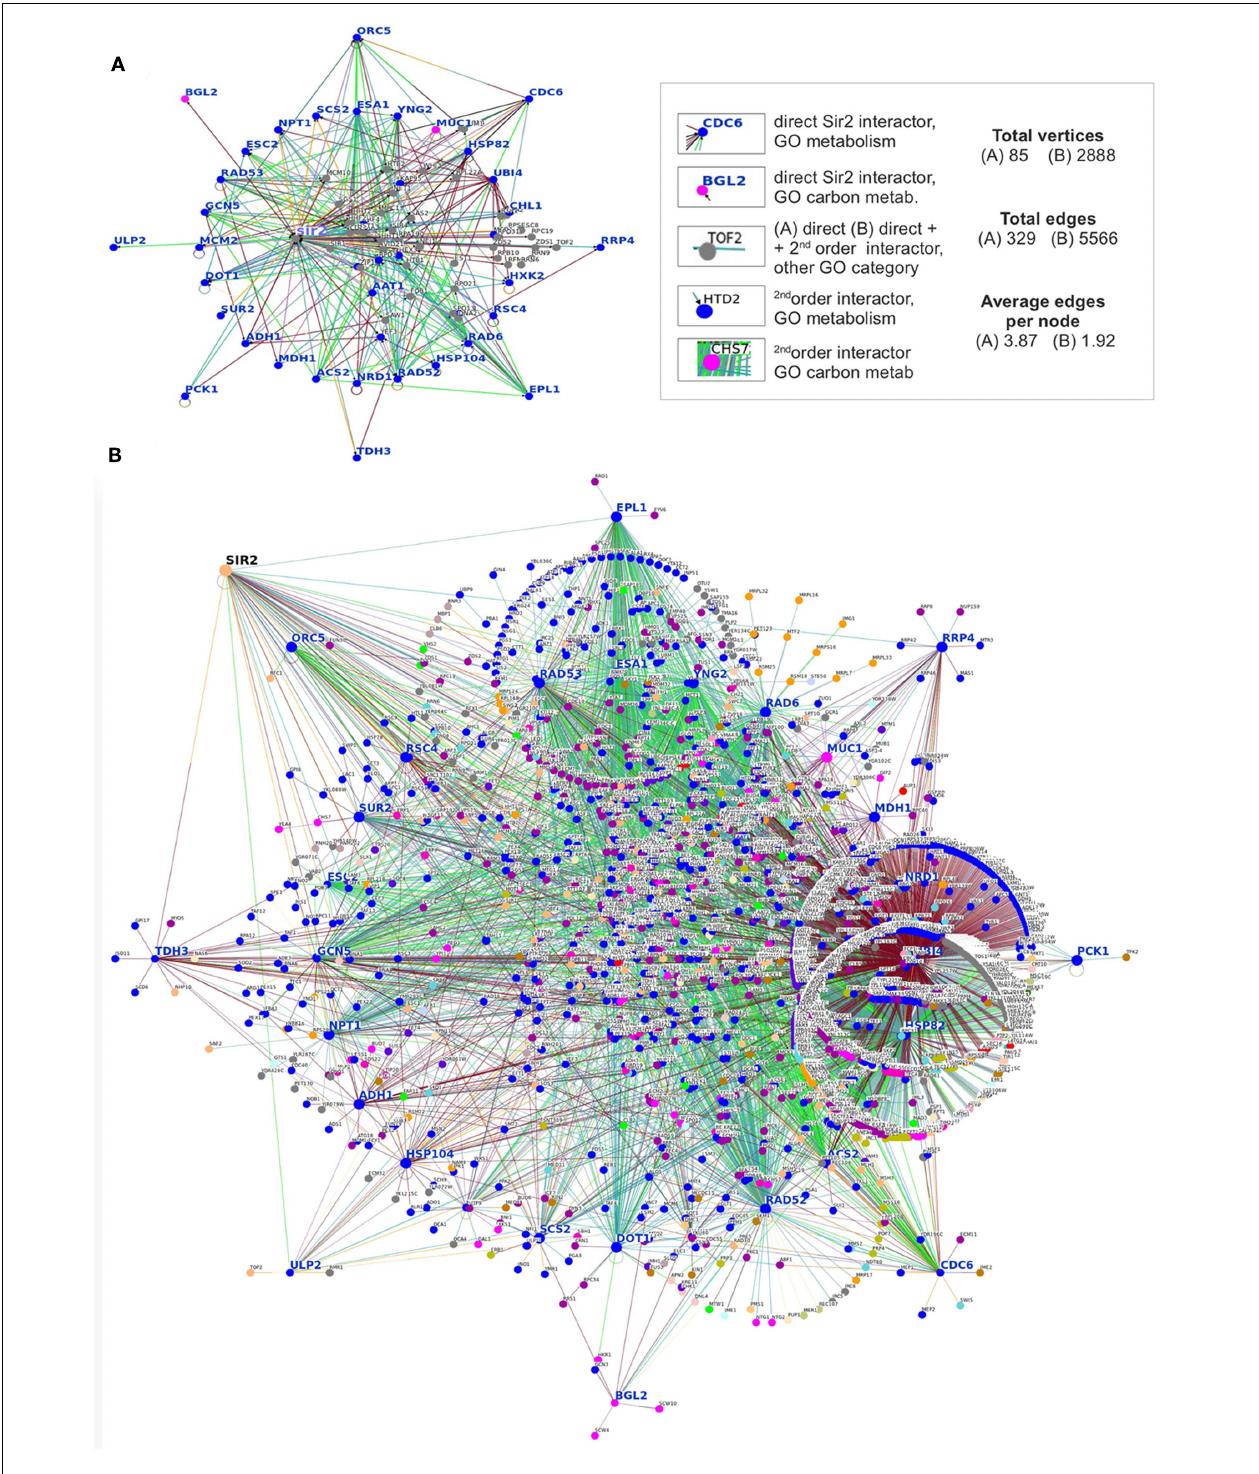
This network containing first and second order metabolism related Sir2 interactors interconnects with 2888 vertices half of the yeast proteome.We apologize that due to this complexity, not all genes names may be readable. (A,B) Physical- and genetic-interactors for Sir2 were obtained from the BioGrid database as of December 2011 and illustrated with OSPrey (Stark et al.,